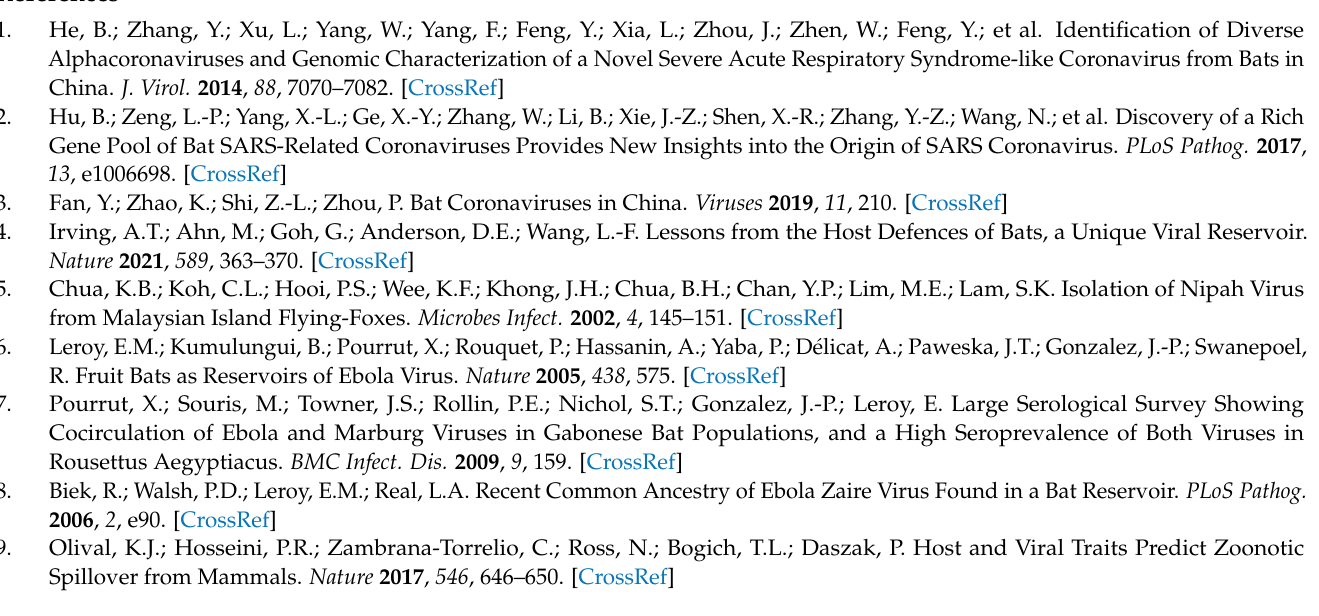
Figure S2: Pairwise identity proteins; Figure S3: Alphacoronavirus spike phylogeny; Figure S4: Sam- pling site in Yunnan province; Table S1: Information on collected samples; Table S2: Number of reads per sample in the main steps of bioinformatic analysis; Table S3: BLASTN results; Table S4: